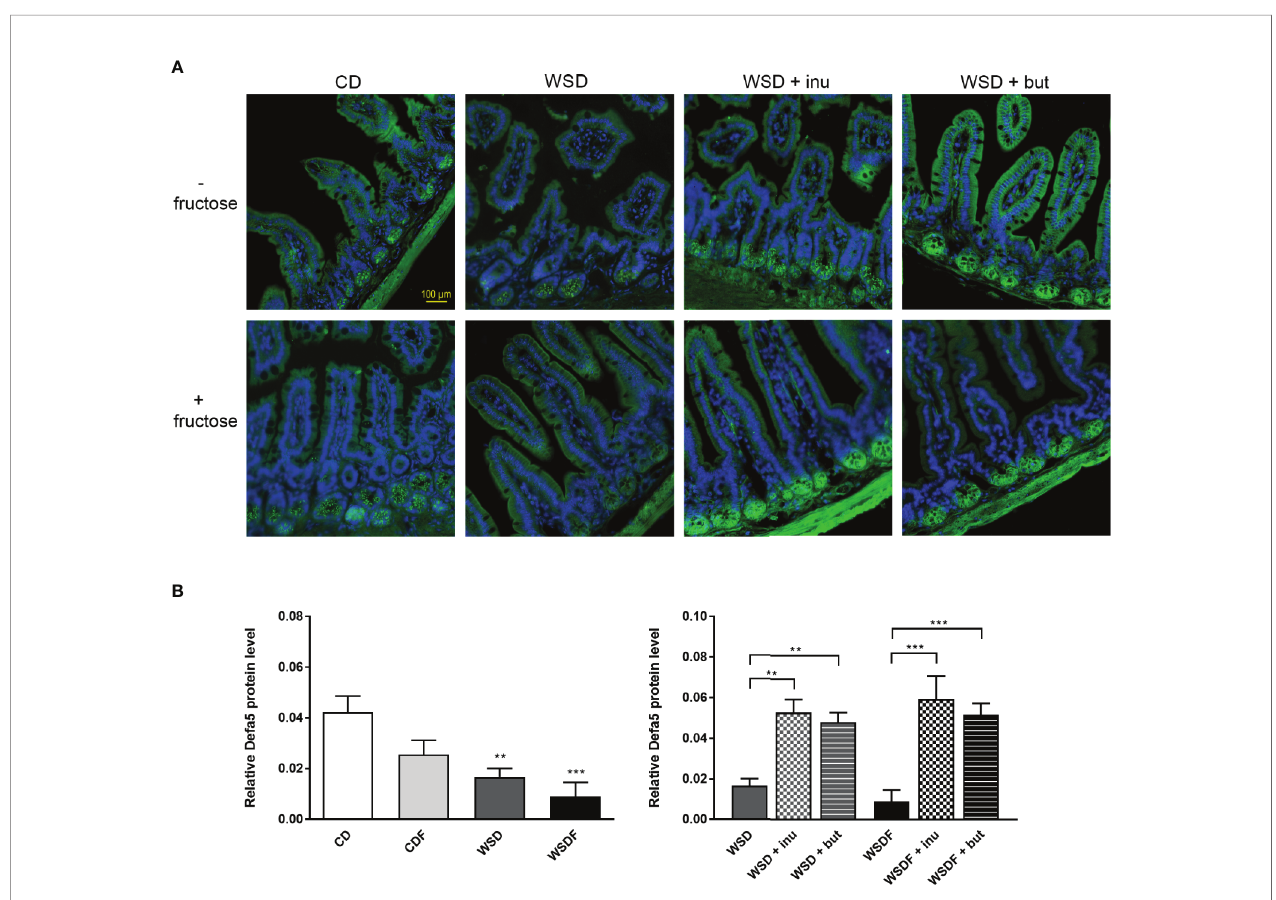
FIGURE 3 | Supplementation with inulin or sodium butyrate induces Defa5 protein expression in ileal Paneth cells. C57BL/6 mice fed different diets as described in Figure 1 are shown. (A) Representative images of Defa5 immuno fl uorescence staining in ileal tissue showing Defa5 expression in green and cell nuclei detected by DAPI in blue. Scale bar: 100 µm. (B) Quanti fi cation of Defa5 expression. Data are presented as means +/- standard error of the mean (SEM). Statistical analysis was performed by one-way ANOVA with Dunnett´s or Sidak´s post-test. Signi fi cant differences are indicated as **p-value < 0.01; ***p-value <